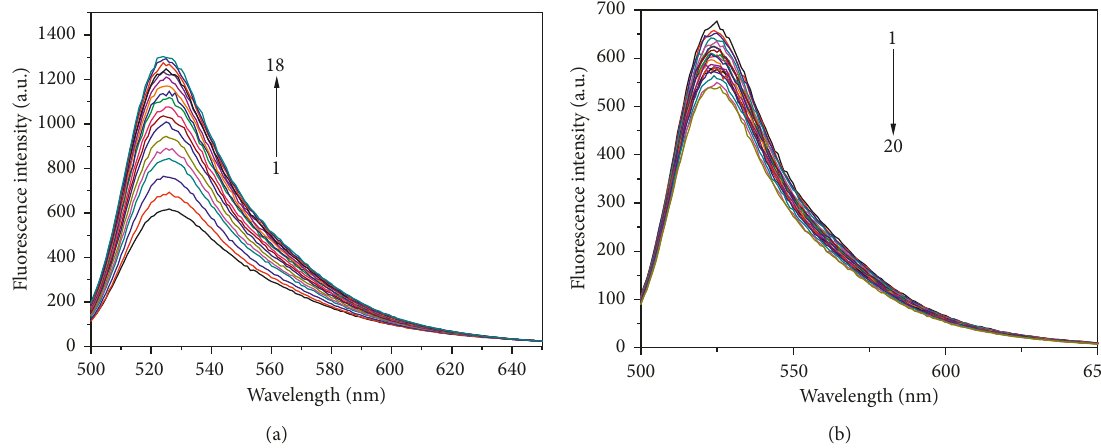
Figure 6: (a) Fluorescence spectra of 4S Green in different concentrations of DNA (pH 7.40; λ 6 mol 1 ; c c 4S Green 2.5 10 L DNA (cid:31) 1 × 10 (cid:31) × · different concentrations of thulium(III)-arsenazo III complex (pH 7.40; λ ex − − 6 mol 1 ; c c DNA 1 10 L Thulium(III)-arsenazo III (cid:31) 5.00 × 10 (cid:31) × · − −